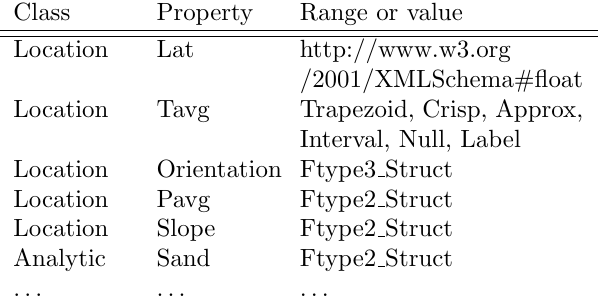
Table 3. Partial domain ontology of the Land database example.